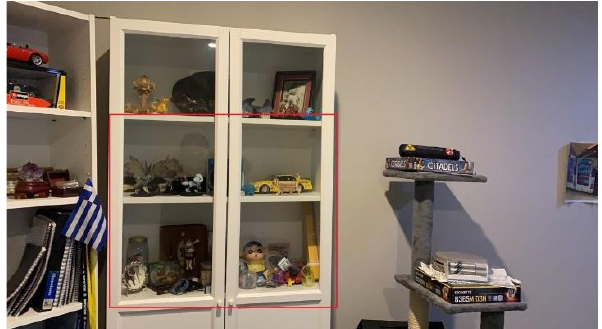
Figure 7. A cabinet misclassified as vending machine